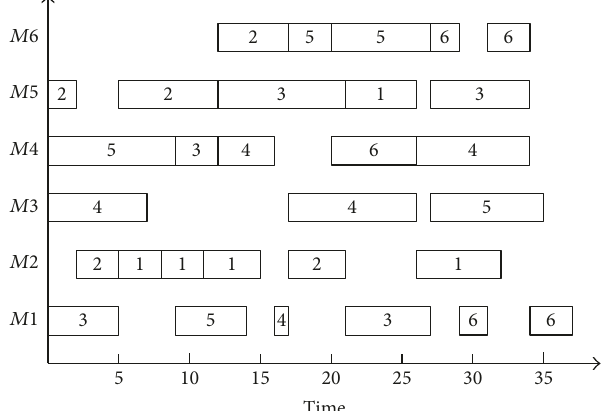
Figure 22: Scheduling Gantt chart for DE4 after